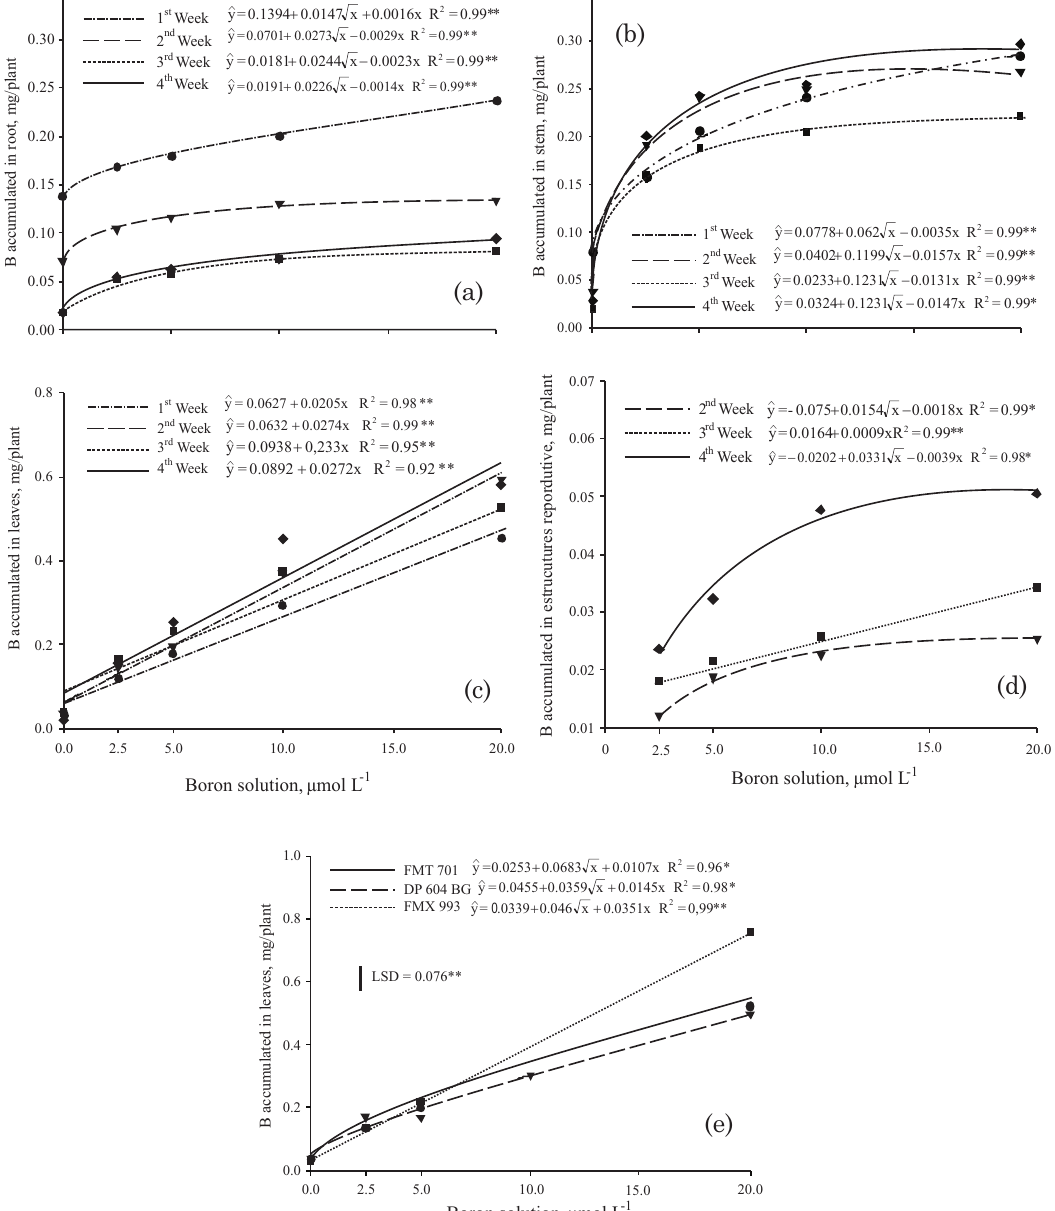
Figure 2. Boron accumulated in root (a), stem (b), leaves (c) and reproductive structures (d) of cotton plants, measured in four harvests in weekly intervals starting at B1, as affected by B rates in the nutrient solution. When there was no B in solution all the reproductive structures shed and there was B accumulation at zero B (d). * and ** significant at 5 and 1 %, respectively. (cid:122)(cid:122)(cid:122)(cid:122)(cid:122) , , , = 1 st , 2 nd , 3 rd and 4 th week, respectively. (cid:122)(cid:122)(cid:122)(cid:122)(cid:122) , , = FMT 701, DP 604BG and FMX 993,